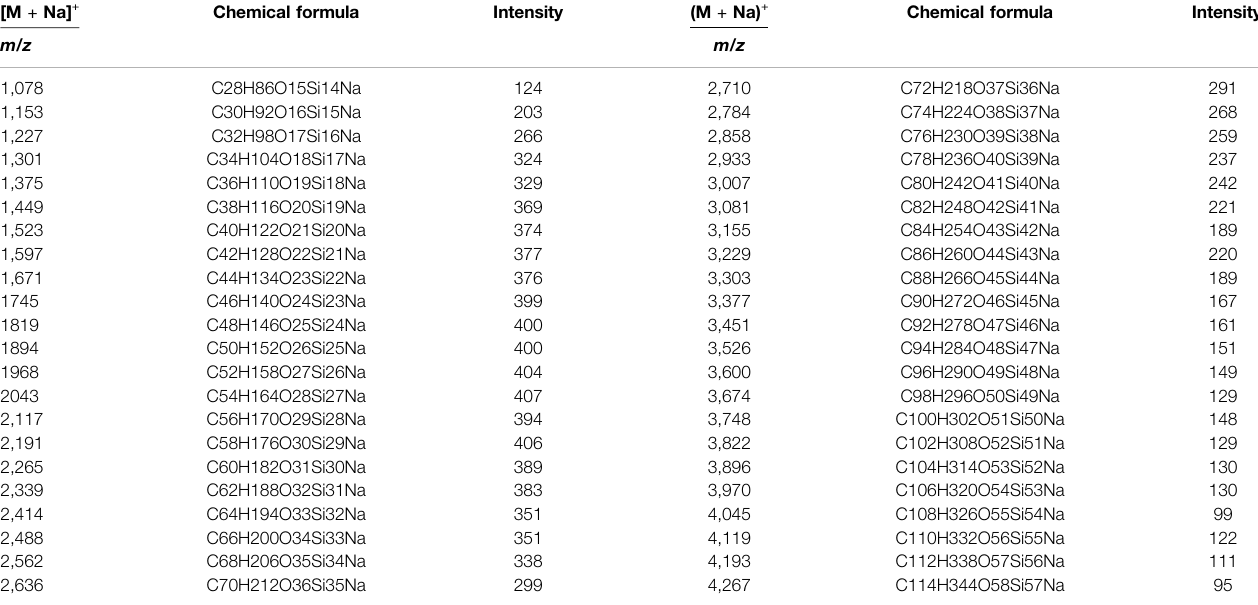
TABLE 1 | MALDI-TOF MS data of 30 cP hydroxyl silicone oil. [M + Na] + Chemical formula Intensity (M + Na) +